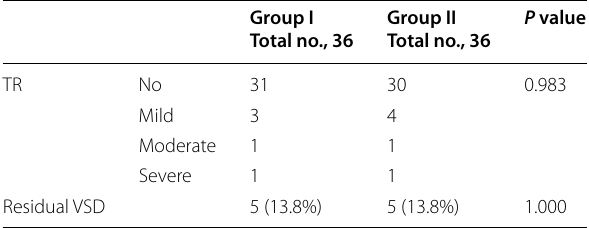
Table 4 Comparison of postoperative echocardiogram findings between groups I &